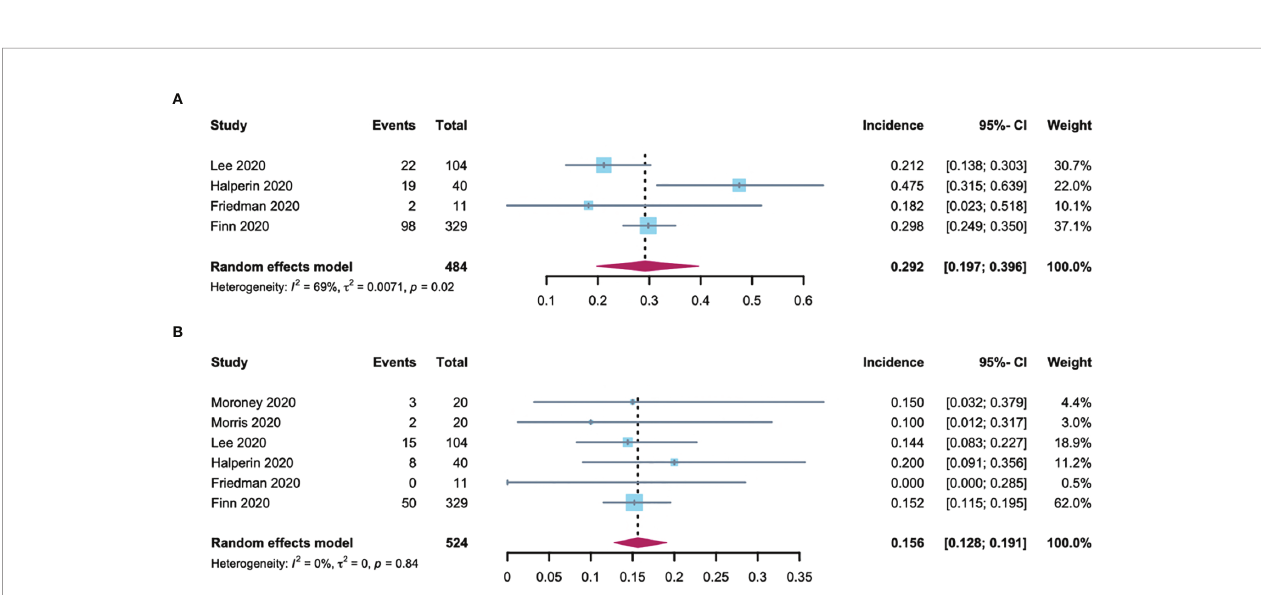
FIGURE 3 | Forest plot of the A-B-associated hypertension incidence in RCC patients. (A) incidences of all-grade hypertension with RCC; (B) incidences of high- grade hypertension with